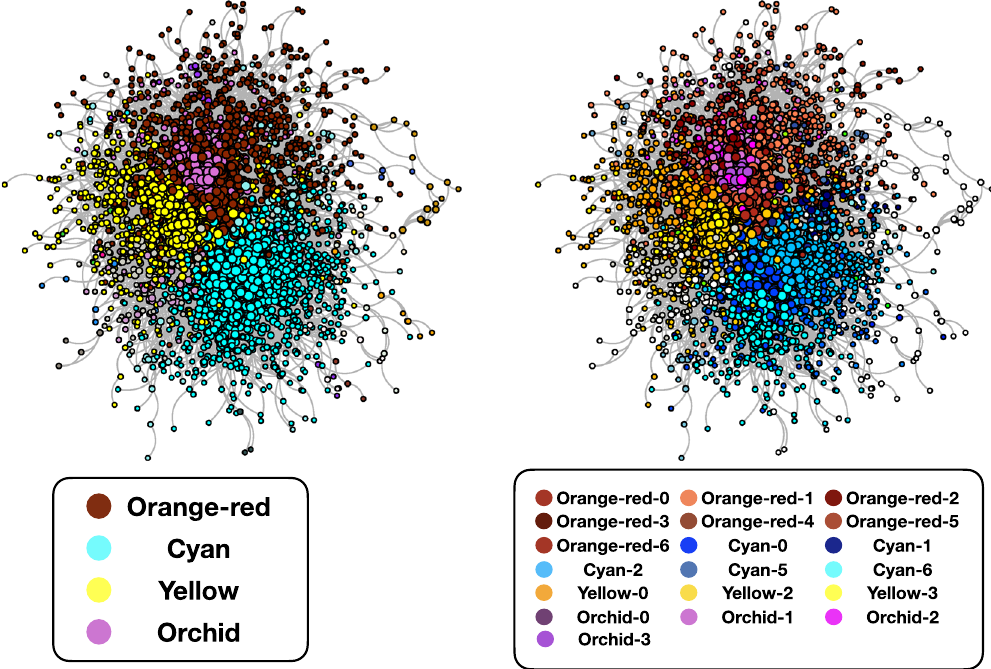
Figure 3. The Largest Connected Component of the validated projected network of users. The dimension of the nodes is proportional to the logarithm of their degree. In the left panel, the different node colors represent the various communities, as detected by Louvain algorithm; in the right panel the colors identify the subcommunities (nodes that do not fall in one of the main subcommunities are plotted in white). Please note that the contents of the various subcommunities are indicated in Tables 4,5,6, 7 and